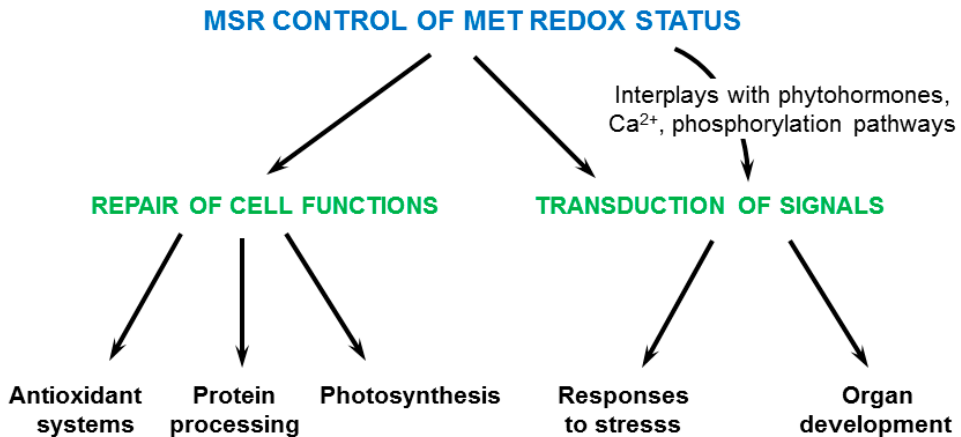
Figure 4. Presumed modes of action of plant MSRs. The proposed functions of MSRs in repair and preservation of antioxidant, protein processing, and photosynthetic systems and in signaling transduction pathways are based on the phenotype of plants modified for MSR expression and on the identity of their possible targets.